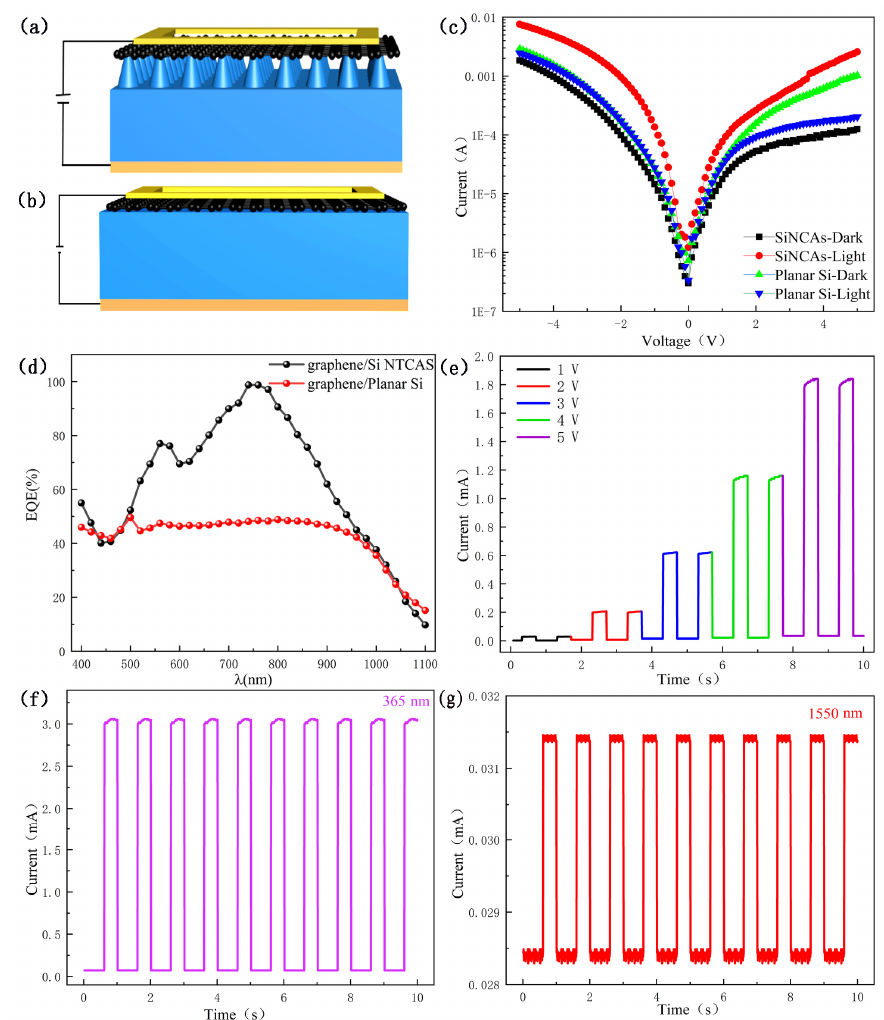
Figure 6. ( a ) Schematic diagram of graphene/Si NTCAs heterojunction device. ( b ) Schematic diagram of graphene/Plabar Si heterojunction device. ( c ) I-V curves of graphene/planar Si and graphene/Si NTCAs heterojunction devices in the dark and under light illumination (780 nm). ( d ) External quantum efficiency (EQE) of the graphene/Si NTCAs and gra- phene/Planar Si heterojunction devices. ( e ) Photoresponse of the graphene/Si NTCAs heterojunction under different bias voltages. Photoresponse of the graphene/Si NTCAs heterojunction under incident light of ( f ) 365 nm (36 mW/cm 2 ) and ( g ) 1550 nm (45 mW/cm 2 ) at a bias of 3 V.